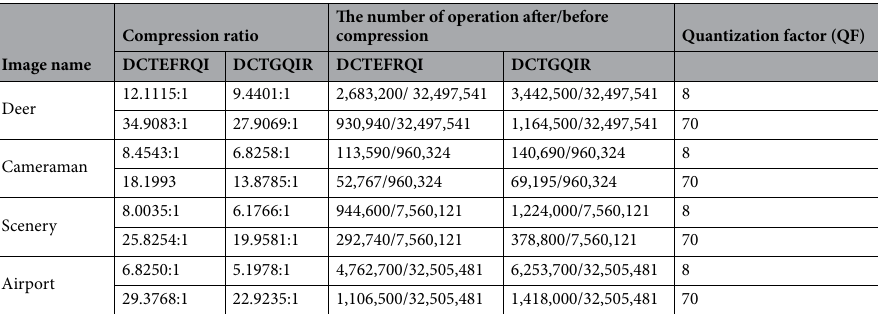
Table 5. Compression ratio comparison including preparation